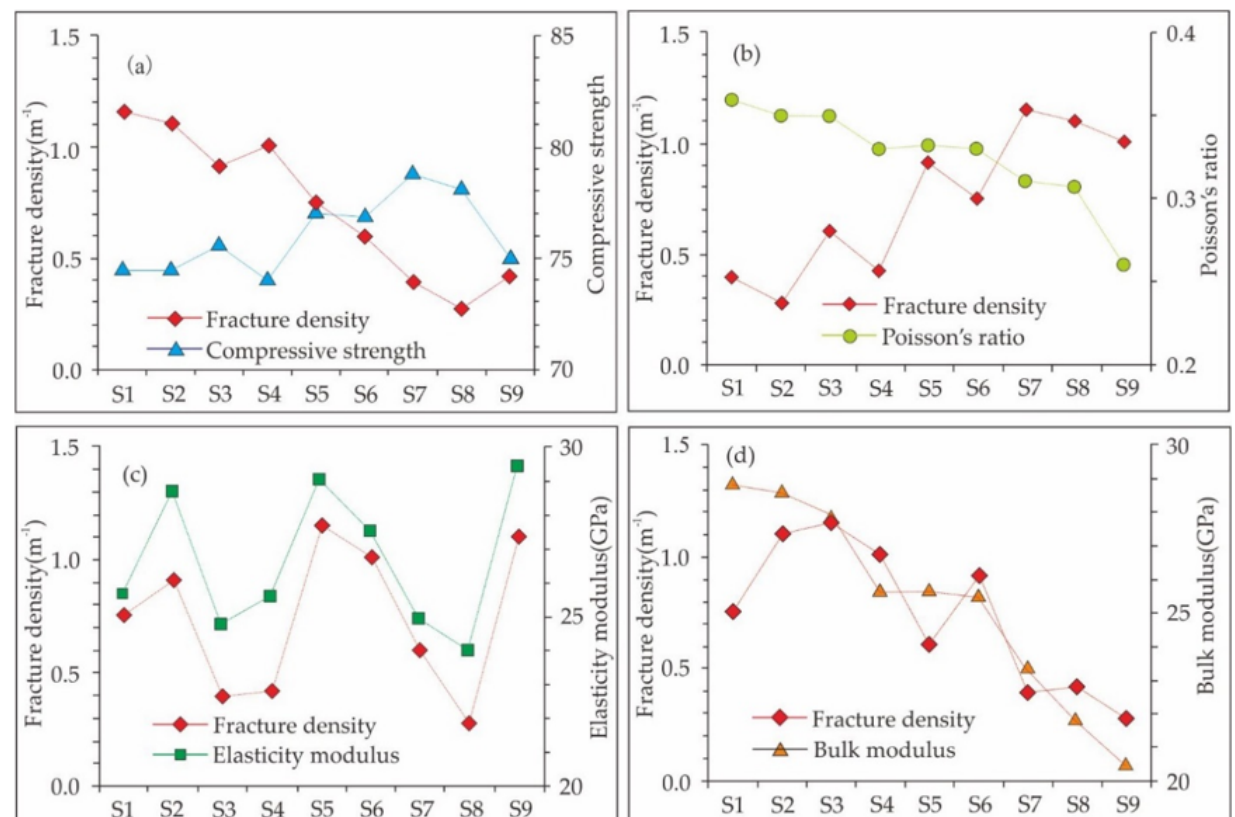
Figure 9. Relationship between rock mechanical parameters and fracture density in Qingshankou shale: ( a ) Compressive strength vs. fracture density; ( b ) elasticity modulus vs. fracture density; ( c ) Poisson’s ratio vs. fracture density; ( d ) Bulk modulus vs. fracture density. Samples were collected from cores. The 9 samples have been marked as S1–S9, respectively.